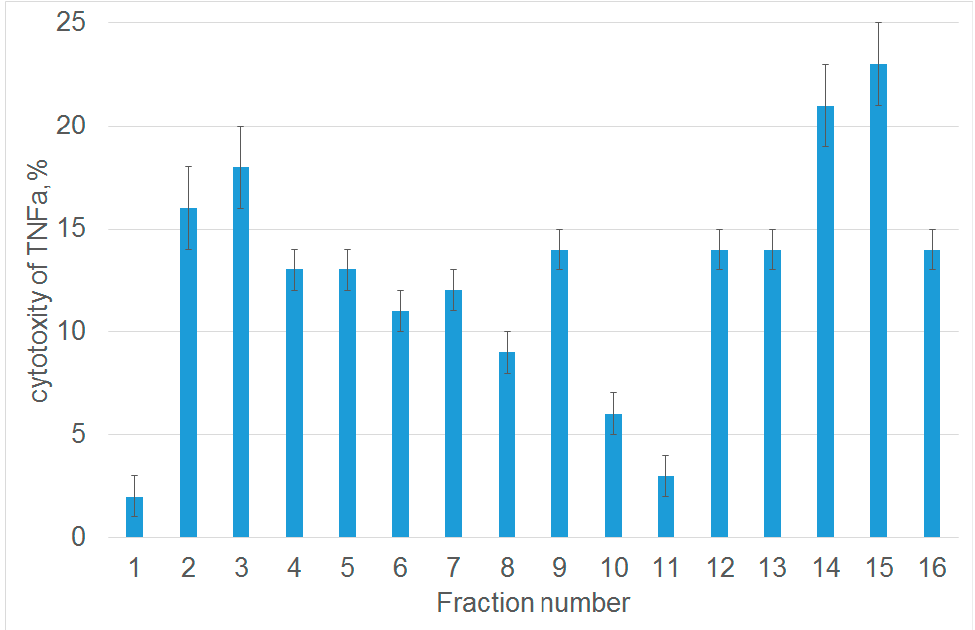
Figure 1. The peptides obtained after tryptic hydrolysis of Tag7 inhibit the cytotoxic activity of TNF α . The cytotoxic activity of TNF α (10 − 9 M) after 1 h preincubation of L929 cells in the presence of peptides derived from protein Tag7. A fraction of proteins eluted from the column and dissolved in DMEM medium was added to L929 cells; TNF α was added 1 h later. Cytotoxicity was measured after incubation for 20 h. Data are presented as the means ± SEM from three independent cytotoxic assays.